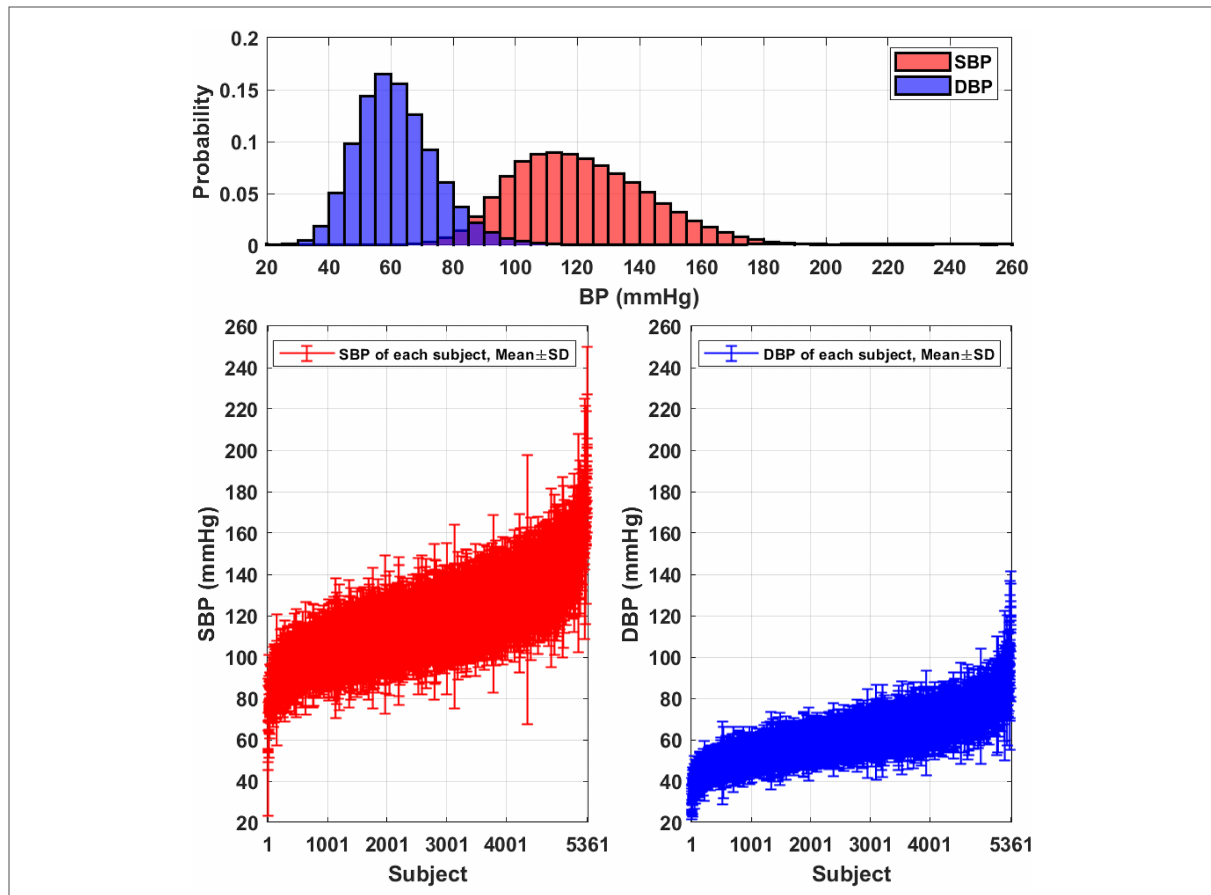
FIGURE 3 Distributions of the SBP and DBP in the PulseDB dataset. Top: histogram showing the distribution of reference SBP and DBP. Bottom: plot of subject- speci fi c mean and standard deviation (SD) of SBP (left) and DBP